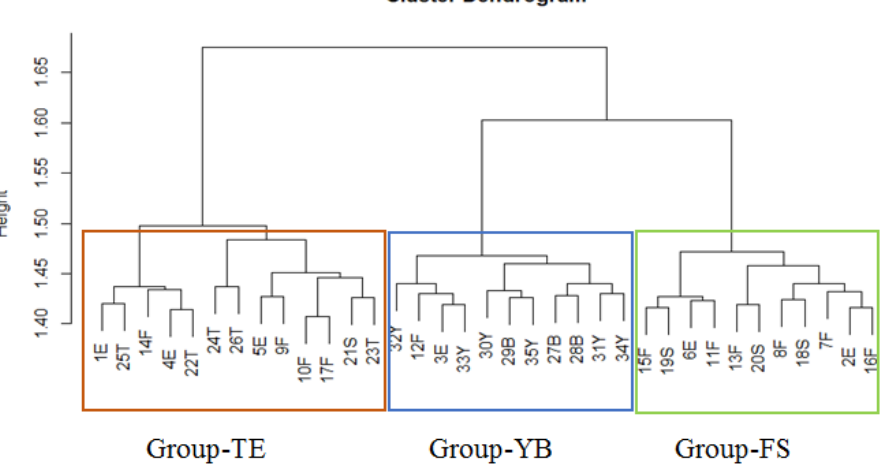
Figure 2. Agglomerative cluster analysis of 35 Trianthema portulacastrum samples subdivided into three groups (clusters) based on combined macromorphological characteristics, photosynthetic pigment analysis, and germination traits.